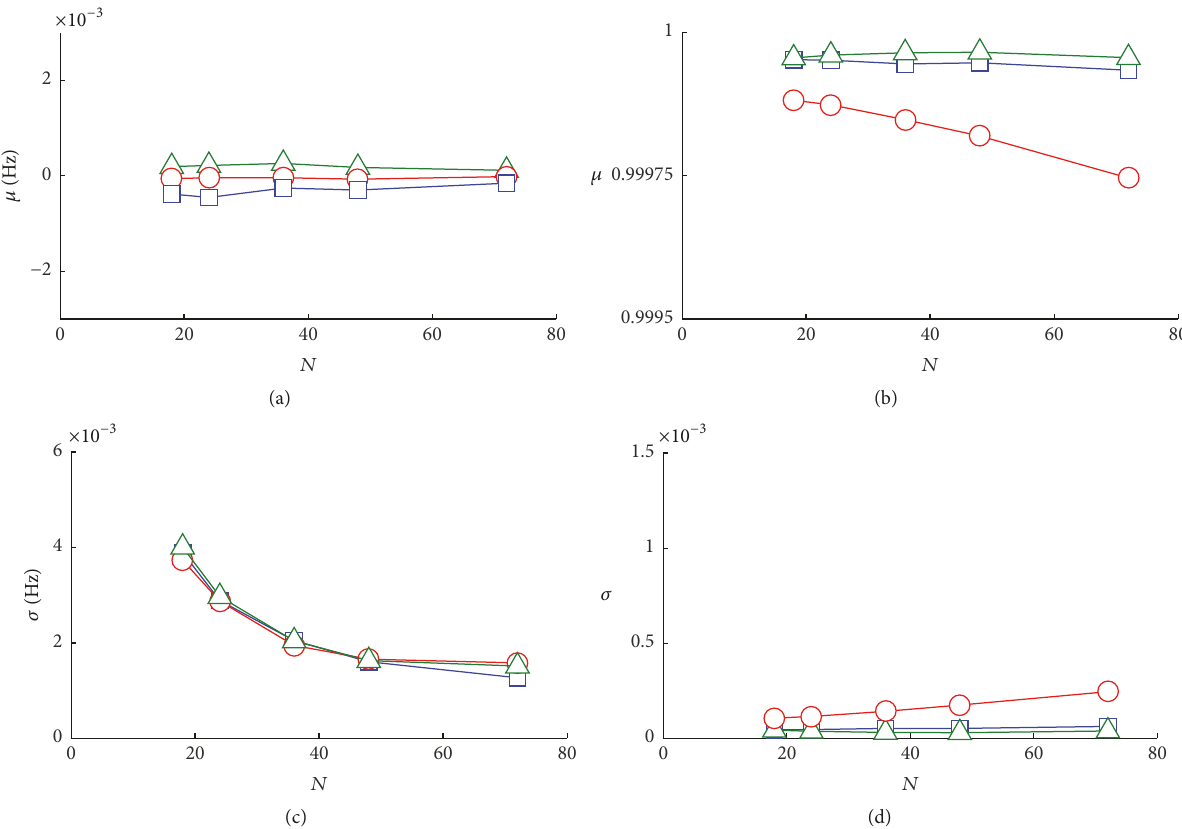
Figure 6: Results of the MCMC simulations for FDD as function of N ( R = 5mHz): mean value of the error for the eigenfrequency estimation (a), mean value of the MAC (b), 𝜎 of the error for the eigenfrequency estimation (c), and 𝜎 for the MAC (d). Curves with squares ( ◻ ) for the first mode, with circles ( I ) for the second mode, and with triangles ( 󳵻 ) for the third mode.